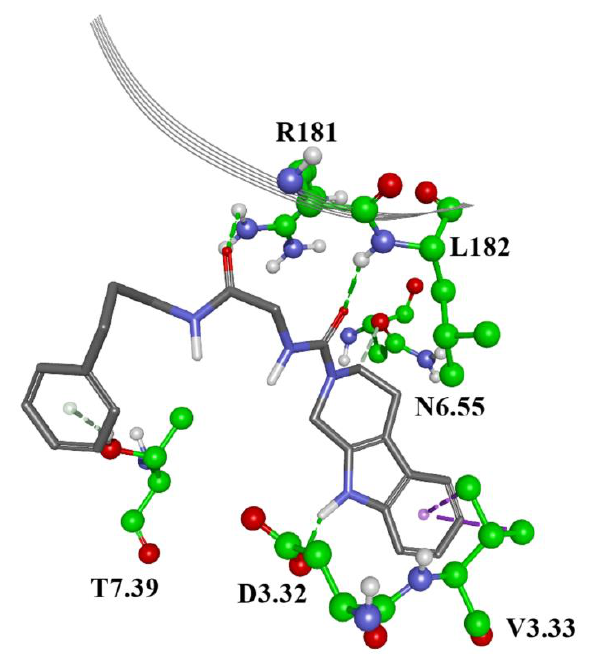
Figure 5. Homology model of 5HT6 receptor with docked second best candidate compound ZINC20762773 and interacting AA residues. Green lines: hydrogen bonds; purple: aromatic in- teractions; grey: hydrophobic interactions; orange: salt bridge or anion—PI interaction.